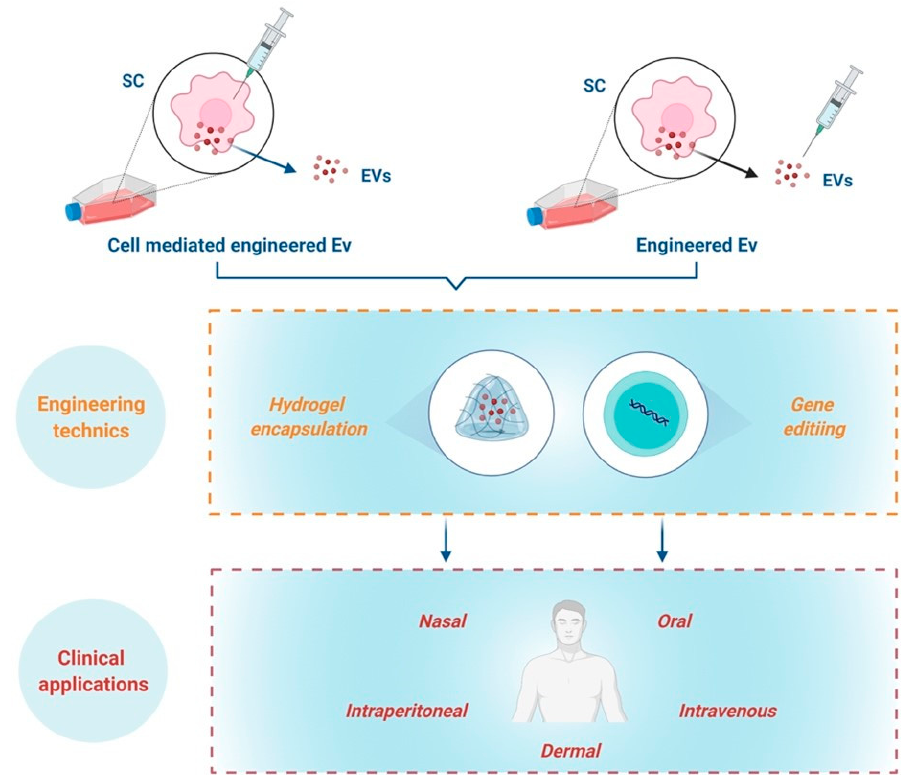
Figure 4. Schematic representation of engineering approaches towards clinical applications.